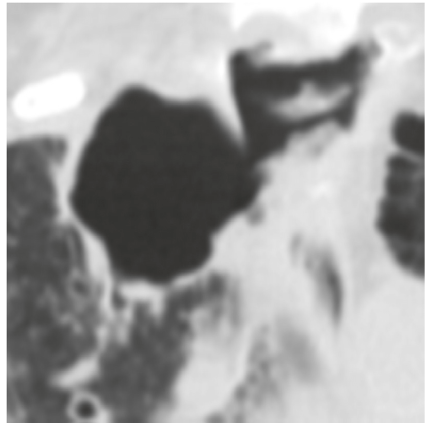
Figure 6: CT chest demonstrating contiguity of mass with